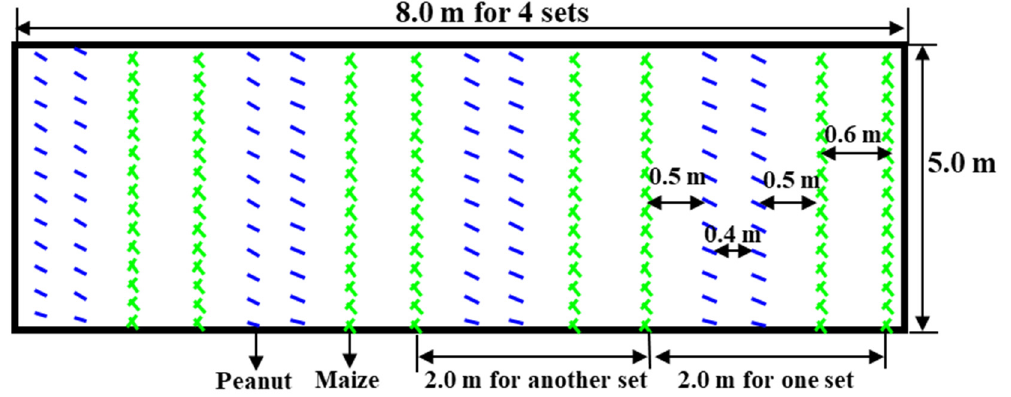
Figure 1. Diagrammatic representation of the strip intercropping.